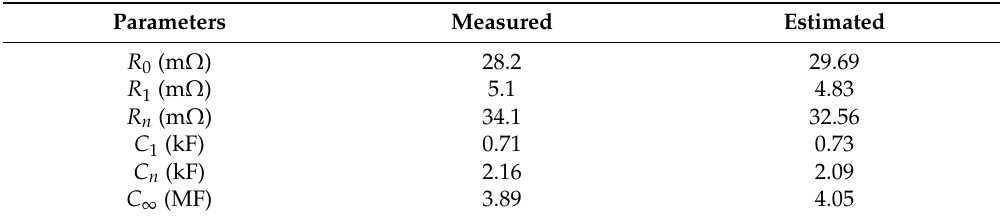
Table 20. Results of Case 9 for Ni-MH.